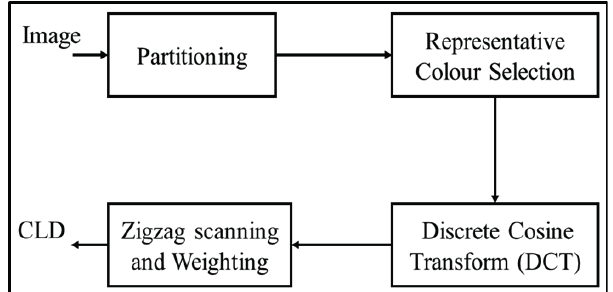
Fig. 2. Colour Layout Descriptor process of feature extraction.